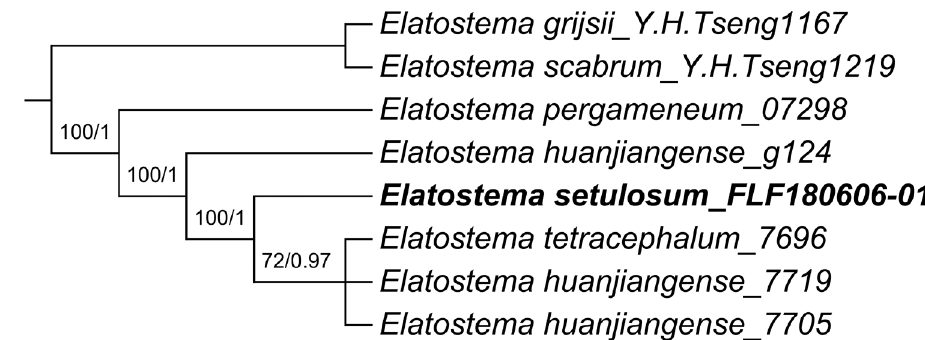
Figure 1. Maximum parsimony phylogenetic tree based on the combined trnH - psbA and ITS data, showing relationships of Elatostema huanjiangense , E. pergameneum , E. setulosum and E. tetracephalum . Numbers on the branches indicate bootstrap values (≥60%) of the maximum parsimony analysis and the posterior probability (≥0.8) of Bayesian inference analysis.